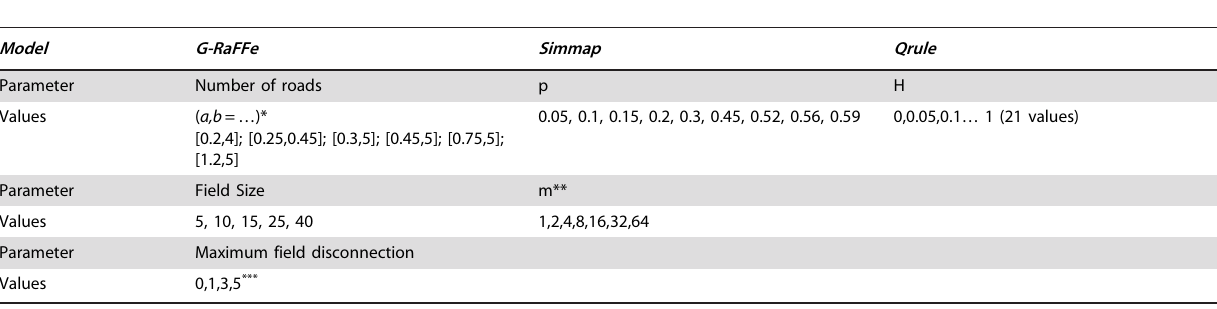
Table 1. Input parameters explored by the models G-RaFFe , Qrule and Simmap